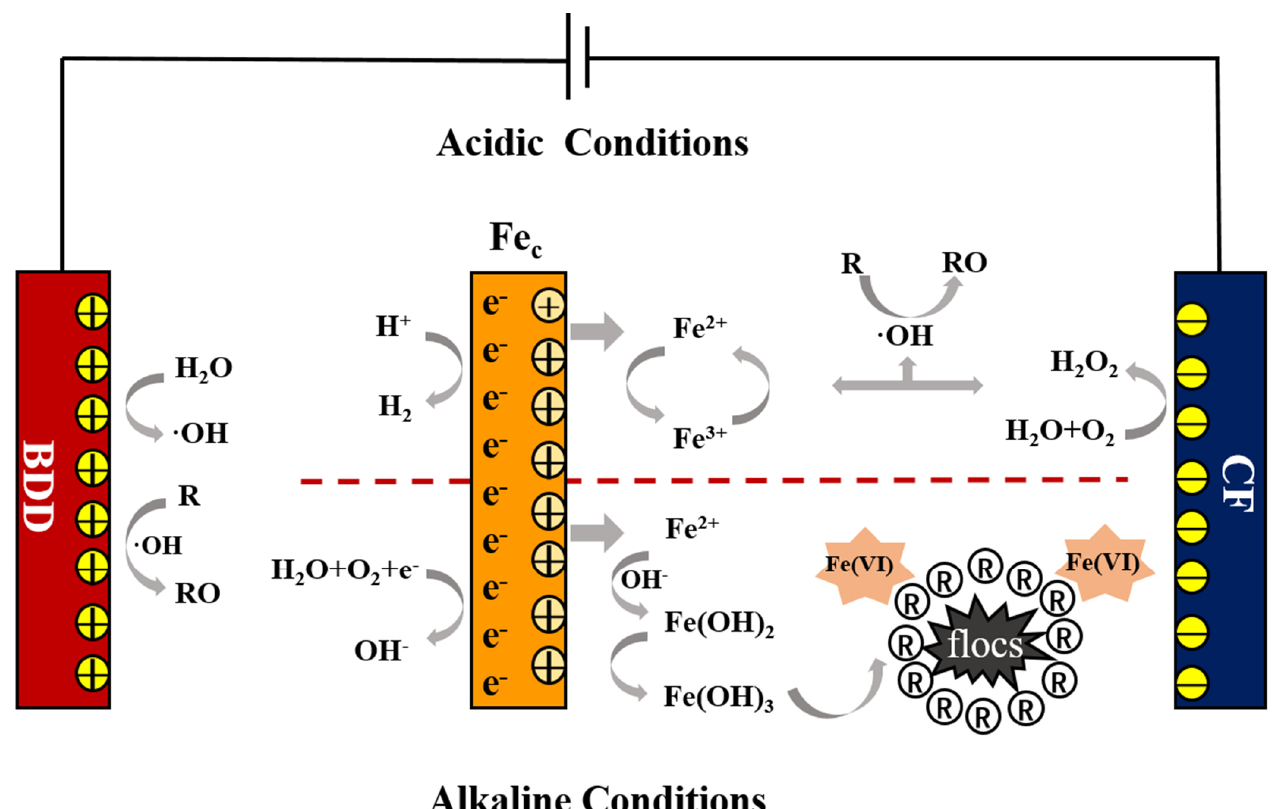
Figure 1. Schematic diagram for mechanism of BDD–Fe c –CF system.